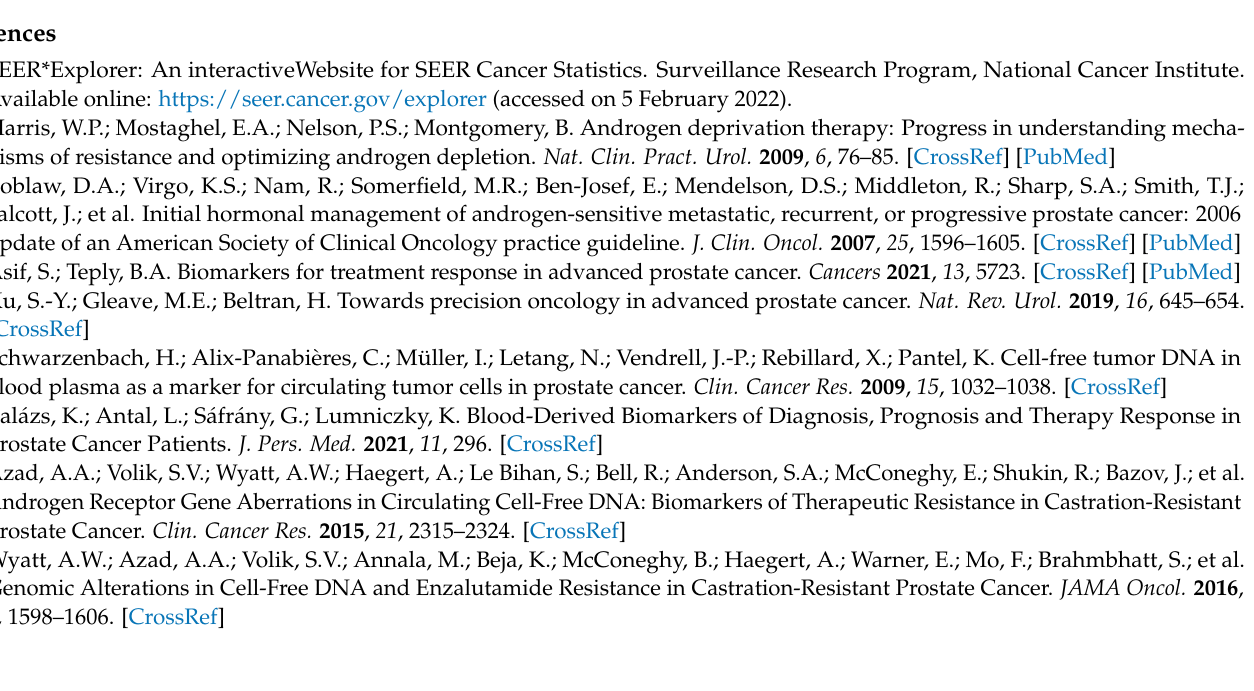
Abbreviations: AR = androgen receptor; ARATs = androgen receptor-axis targeted therapies; BiTE = bispecific T-cell engager; dMMR = deficient mismatch repair; CTLA-4 = cytotoxic T-lymphocyte associated antigen-4; DNA = deoxyribonucleic acid; HRR = homologous recombination repair; LHRH = luteinizing hormone-releasing hormone, MSI = microsatellite instability; PARP = poly adenosine diphosphate-ribose polymerase; PD-1 = pro- grammed cell death protein 1; PD-L1 = Programmed cell death ligand-1; PSA = prostate specific antigen; PSMA = prostate-specific membrane antigen; RANK = Receptor activator of nuclear factor kappa-B ligand; TMB = tumor mutational